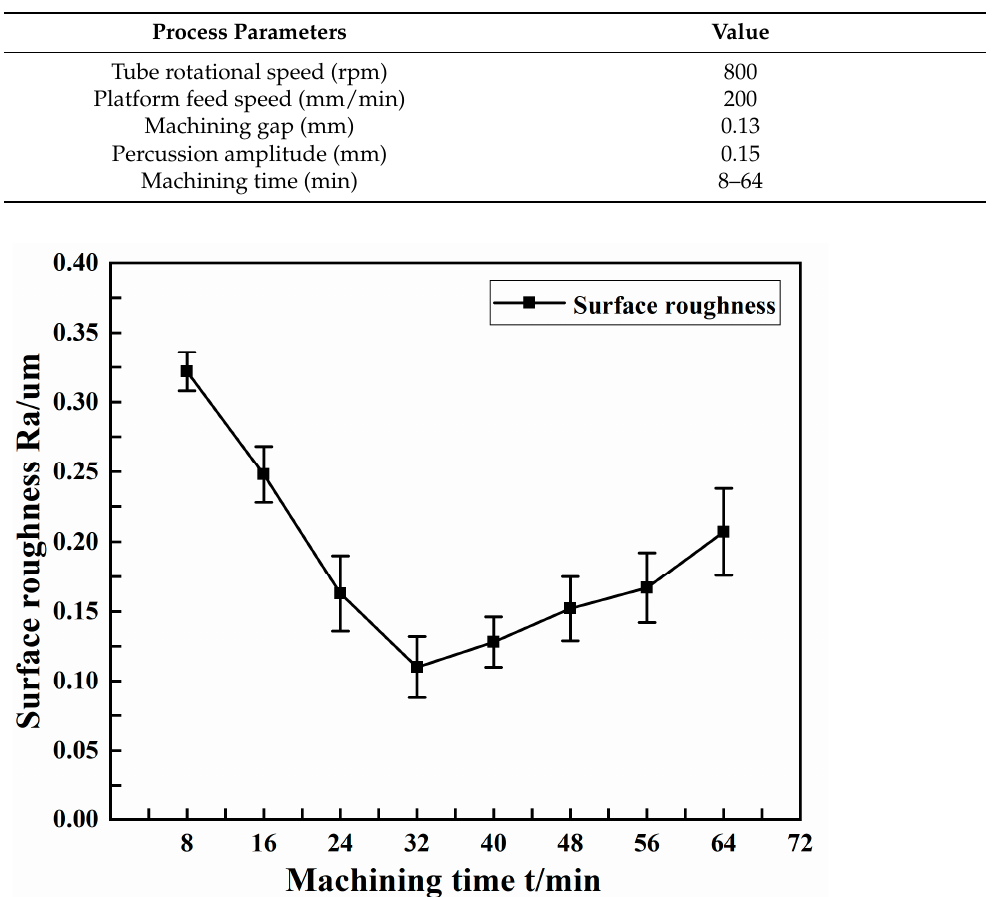
Table 8. Experimental conditions selected for different machining times.